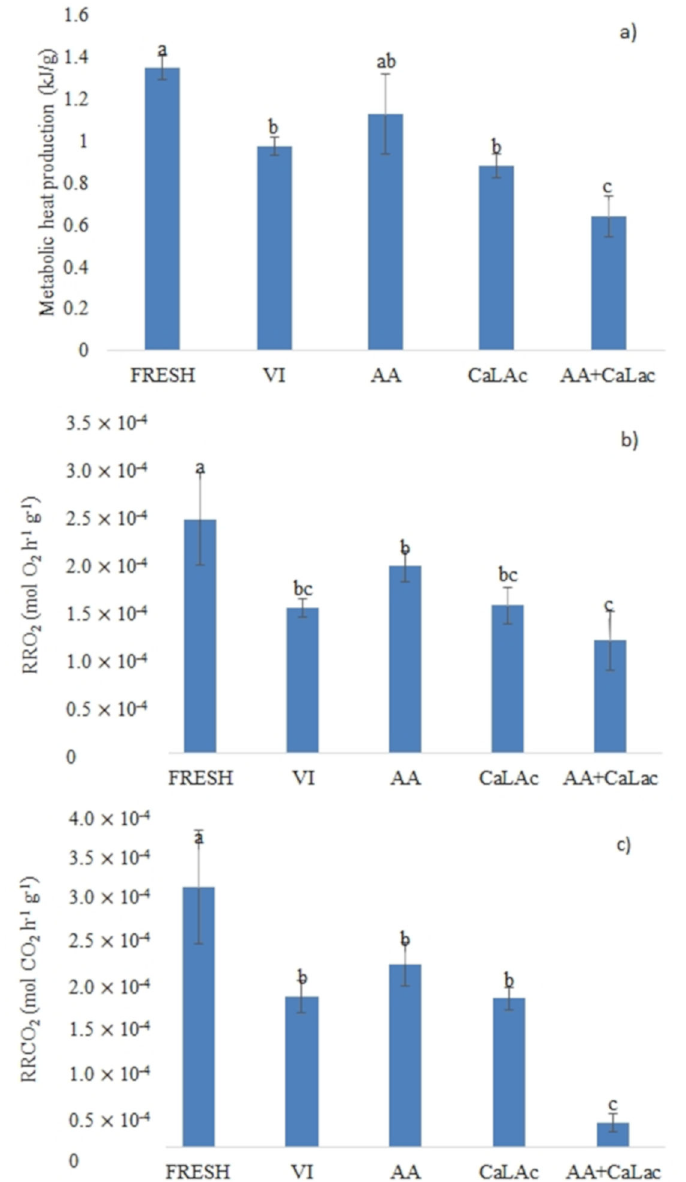
Figure 6. Metabolic heat production measured by isothermal calorimetry ( a ) and respiration rate expressed as O 2 consumption ( b ), and CO 2 production ( c ) of fresh and vacuum-impregnated samples. Bars with different letters indicate significant differences among the samples. Fresh, control sample; VI, vacuum impregnated with isotonic solution; AA, VI with ascorbic acid; Ca-Lac, VI with calcium lactate; AA+CaLac, VI with